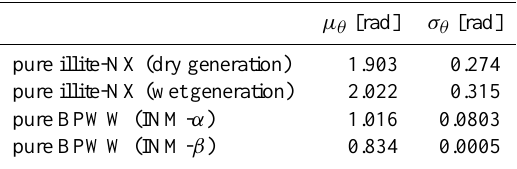
Table 3. Soccerball model parameters used for the calculations shown in Fig. 5. The values for µ θ and σ θ are determined from measurements with the pure substances. The BPWW parameters were directly taken from Augustin et al. (2013). The parameters for illite-NX particles (wet and dry generation) were calculated within this